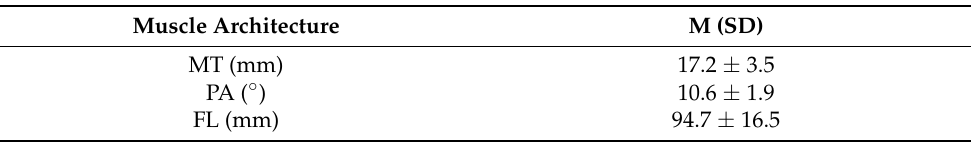
Table 2. Parameters of muscle architecture of vastus lateralis (VL). MT = muscle thickness; PA = pen- nation angle; FL = fascicle